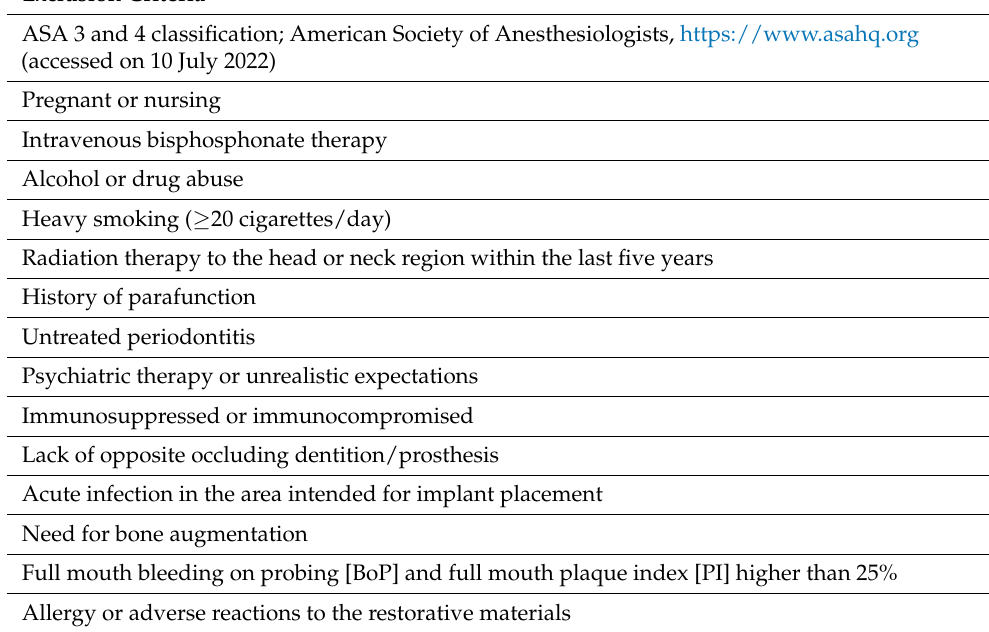
Table 1. Exclusion criteria. Exclusion